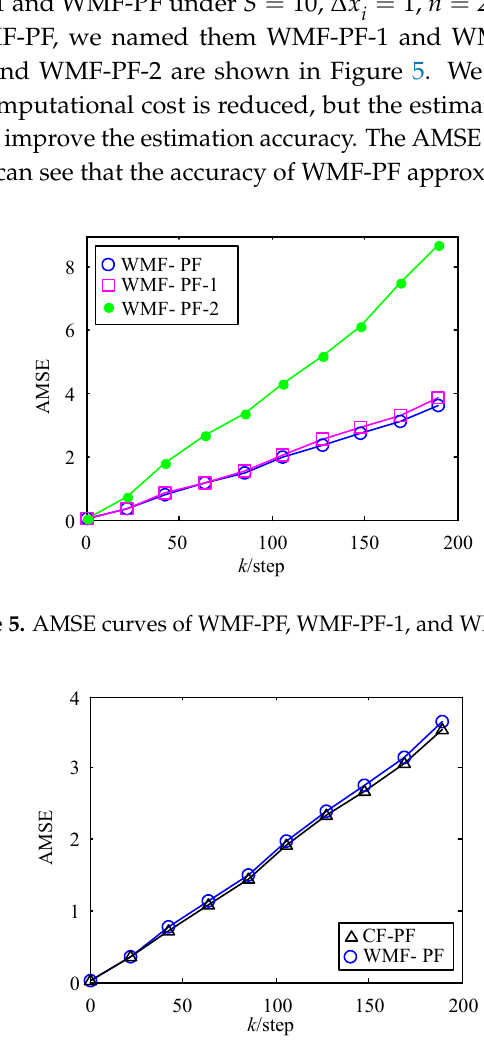
Figure 6. AMSE curves of WMF-PF and CF-PF.